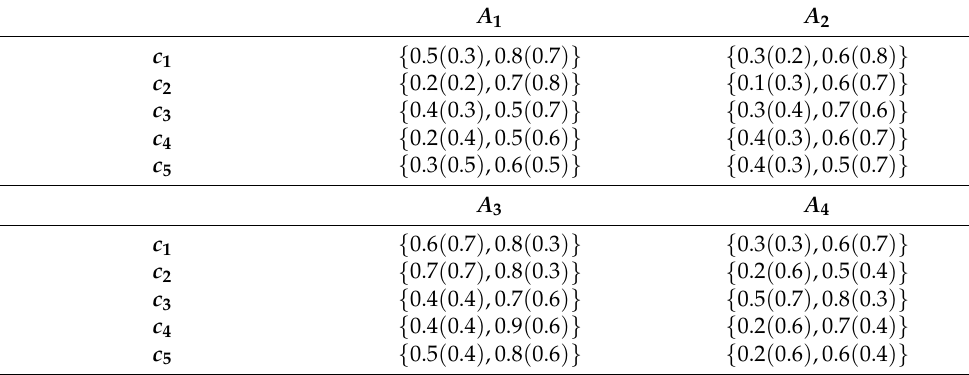
Table 5. Standardized evaluation matrix of Expert 2 ( d 2 ).